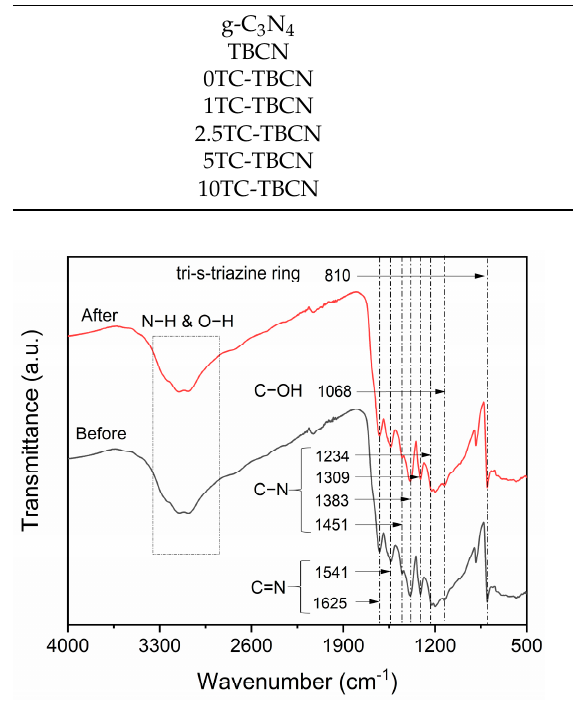
Figure 9. FTIR spectra of 5TC-TBCN before and after the reactions.